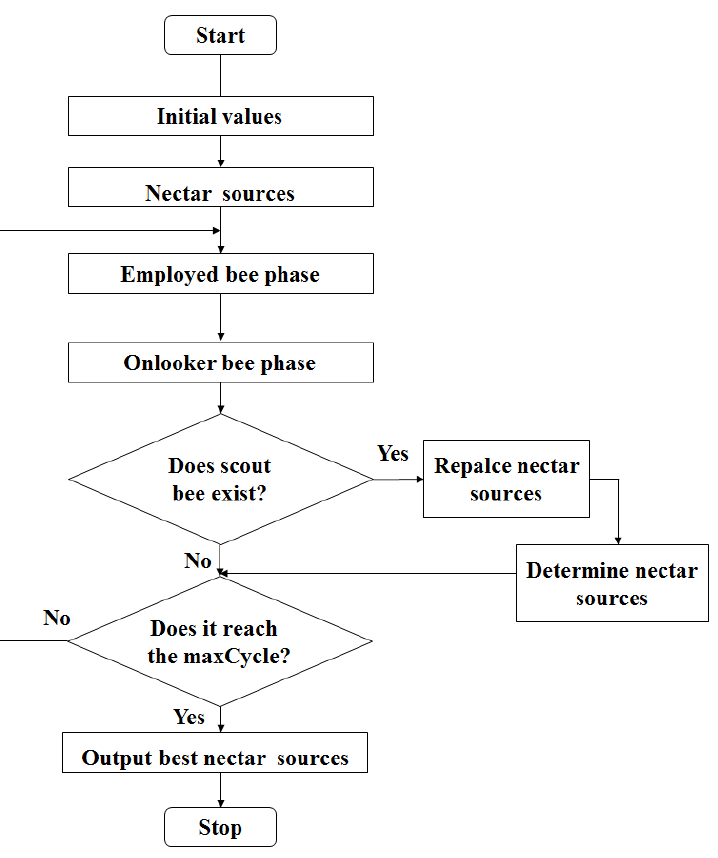
Figure 2. Flowchart of ABC algorithm.